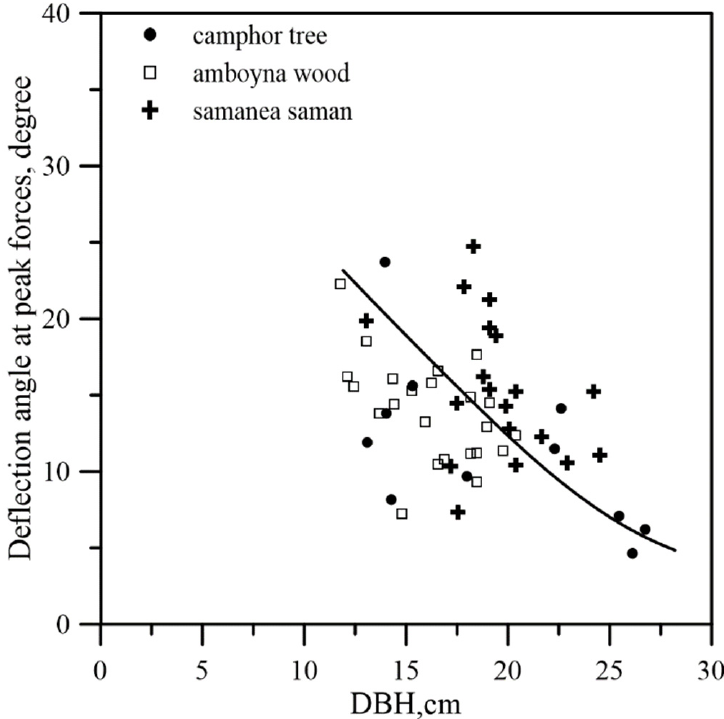
Figure 3. Deflection angle ( θ max ) at maximum pulling forces vs. DBH in near-saturated soil conditions.